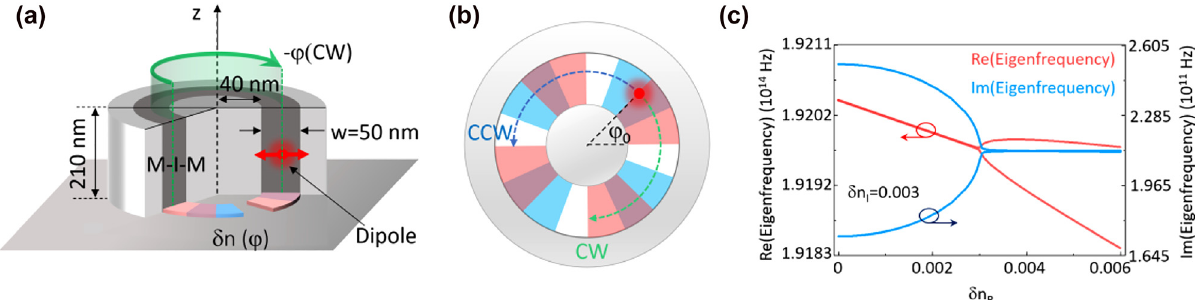
Figure 1: Chiral plasmonic nanocavity. (a)Schematicofachiralplasmonicnanocavity(CPN).M-I-Mrepresentsmetal-insulator-metal.(b)PTsymmetricmodulation δ n ( φ ) inCPN. δ n ( φ ) is divided into 2 l periods for WGMs with orbital angular momentum l . Each period of δ n ( φ ) consists of four angularly equidistant parts of δ n R , δ